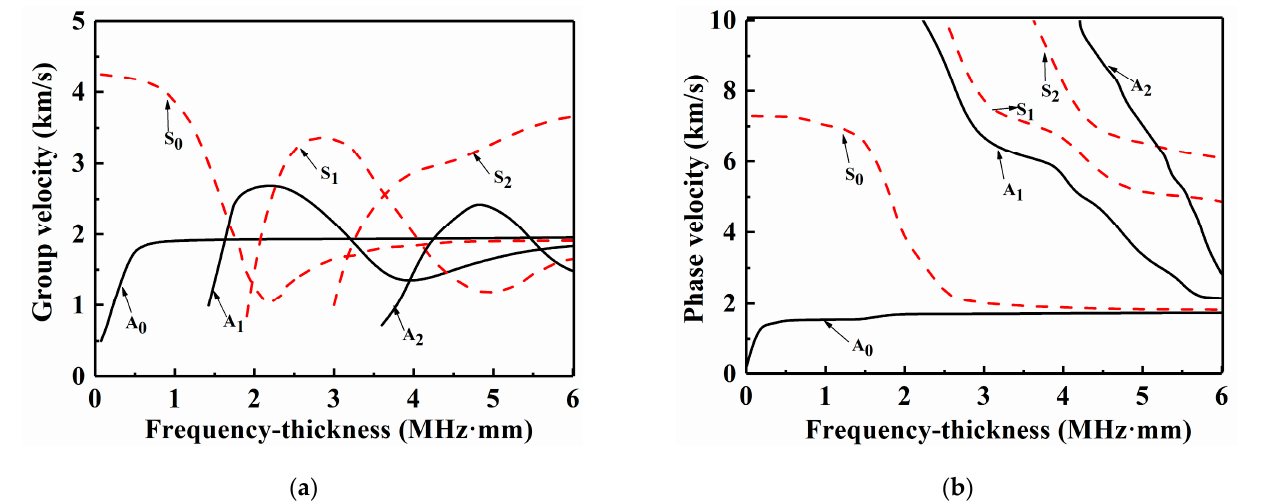
Figure 1. Dispersion curves of the 3.6 mm-thick (0/90) 2s carbon fiber-reinforced polymer (CFRP) laminate: ( a ) group velocity and ( b ) phase velocity.